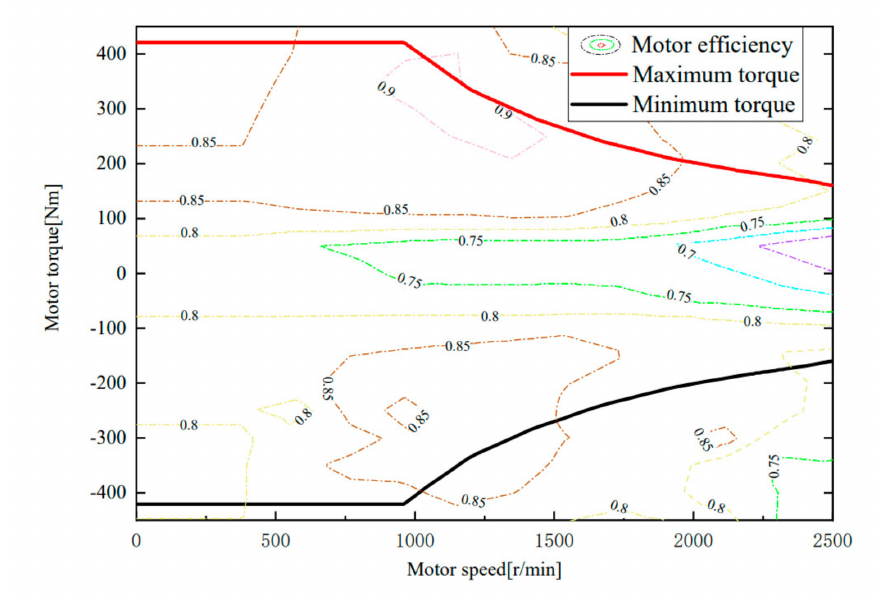
Figure 4. Motor efficiency